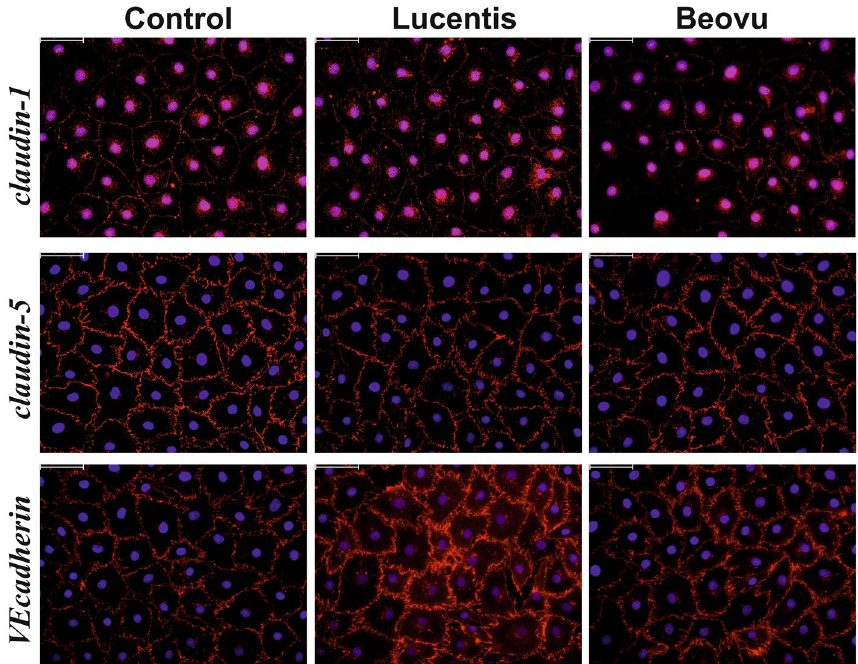
Figure 3. Exposure of iBREC to Beovu but not to Lucentis changed plasma membrane localization of TJ-protein claudin-1. A confluent monolayer of iBREC was treated with Beovu or Lucentis for five days before cells were fixated, and claudin-1 (upper panel), claudin-5 (middle panel) or VEcadherin (lower panel; all in red) were visualized by immunofluorescence stainings with specific antibodies. Lucentis did not markedly change the presence of any of the investigated proteins at the plasma membrane. Whereas subcellular localization of claudin-5 or VEcadherin remained largely unchanged also in the presence of Beovu, the staining specific for claudin-1 was weaker after exposure of the cells to the VEGF-A